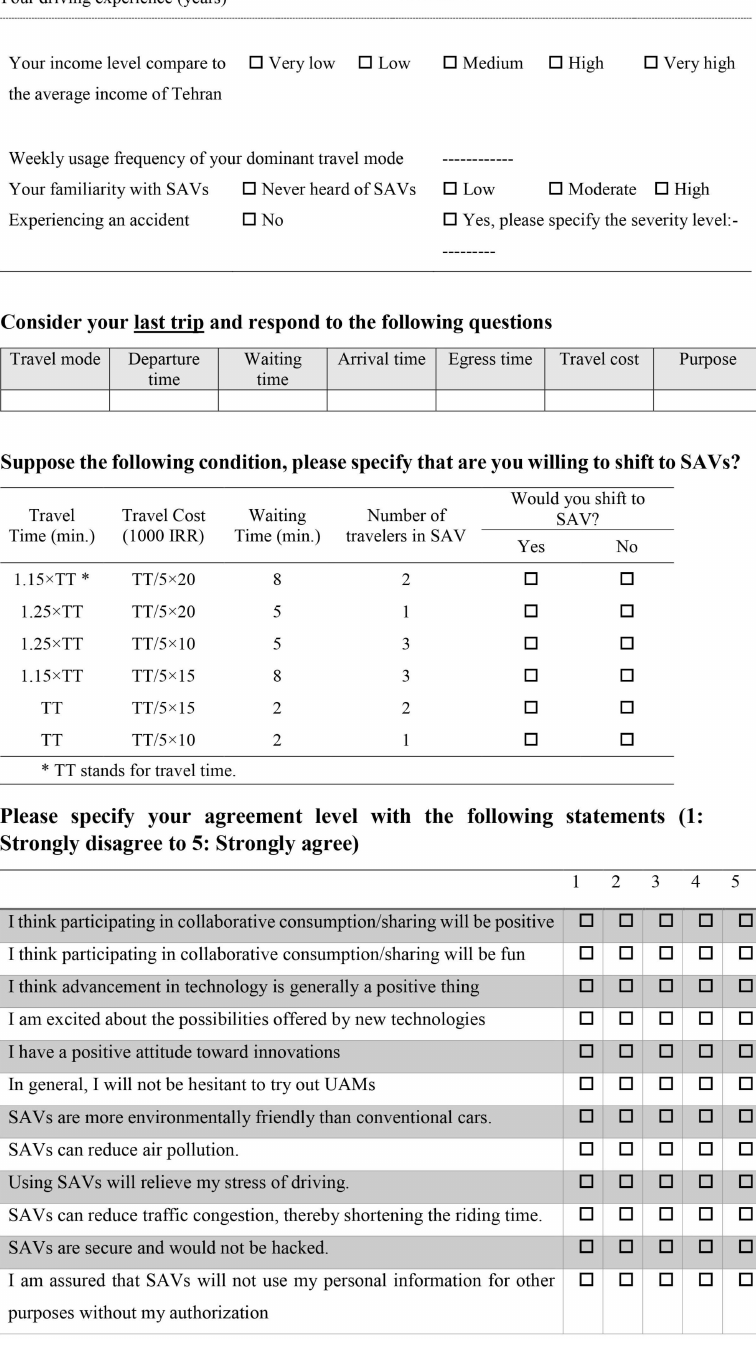
Figure A1. The research